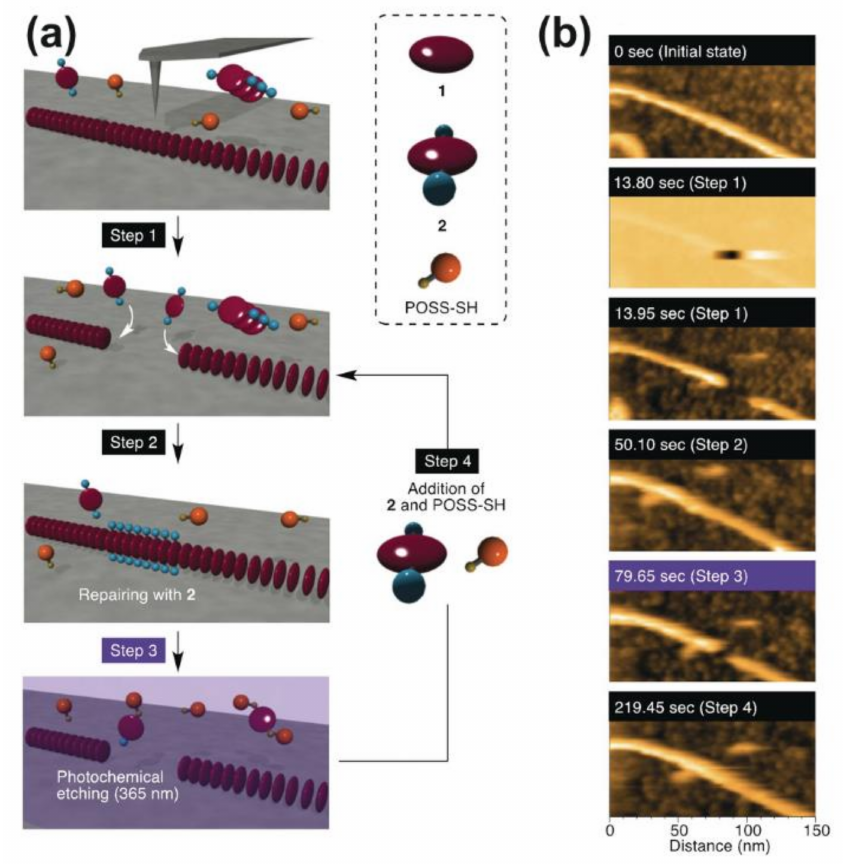
Figure 8. ( a ) Schematic of the manipulation of a segment of the porphyrin-based supramolecular polymer using the atomic force microscopy (AFM) probe. ( b ) AFM images from that process. Reproduced with permission from [89] ©2018, Wiley-VCH Verlag GmbH & Co.